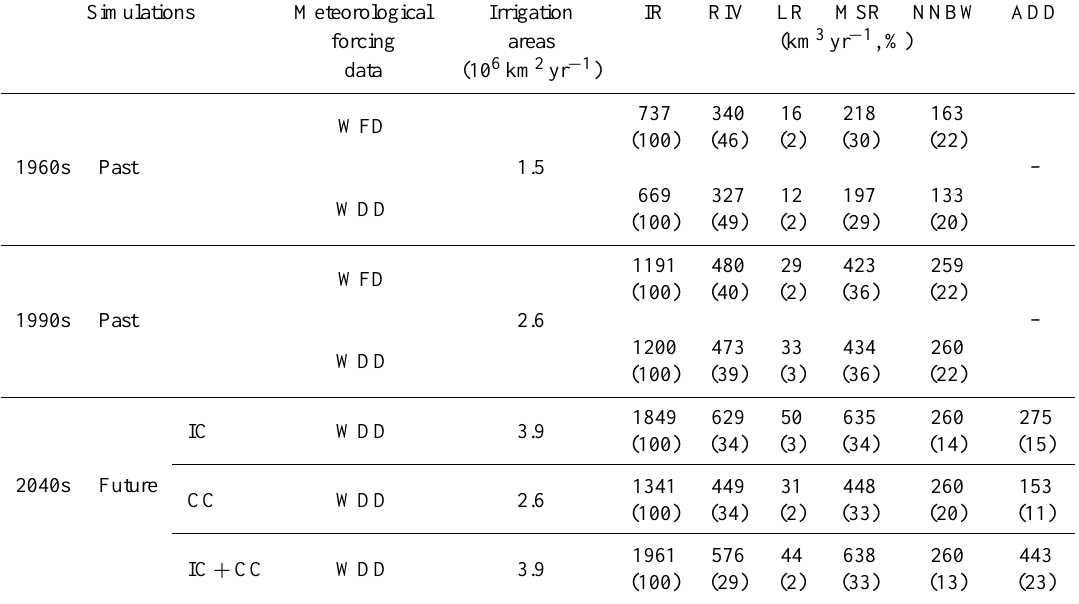
Table 2. Contributions of global average net irrigation water requirements from various water supply sources to the total net irrigation water requirement (km 3 yr − 1 and %) using the WFD and WDD data sets, and irrigation areas (10 6 km 2 yr − 1 ) in the 1960s, 1990s and 2040s. IC, CC, and IC + CC denote simulations with a sole scenario of irrigation area change, a sole scenario of climate change and a scenario with both irrigation area and climate change,